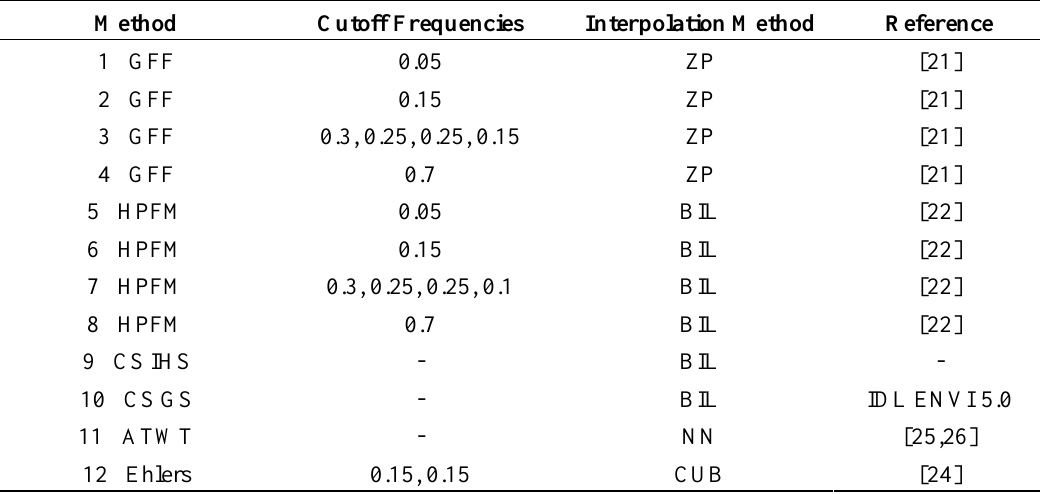
Table 2. List of pansharpening